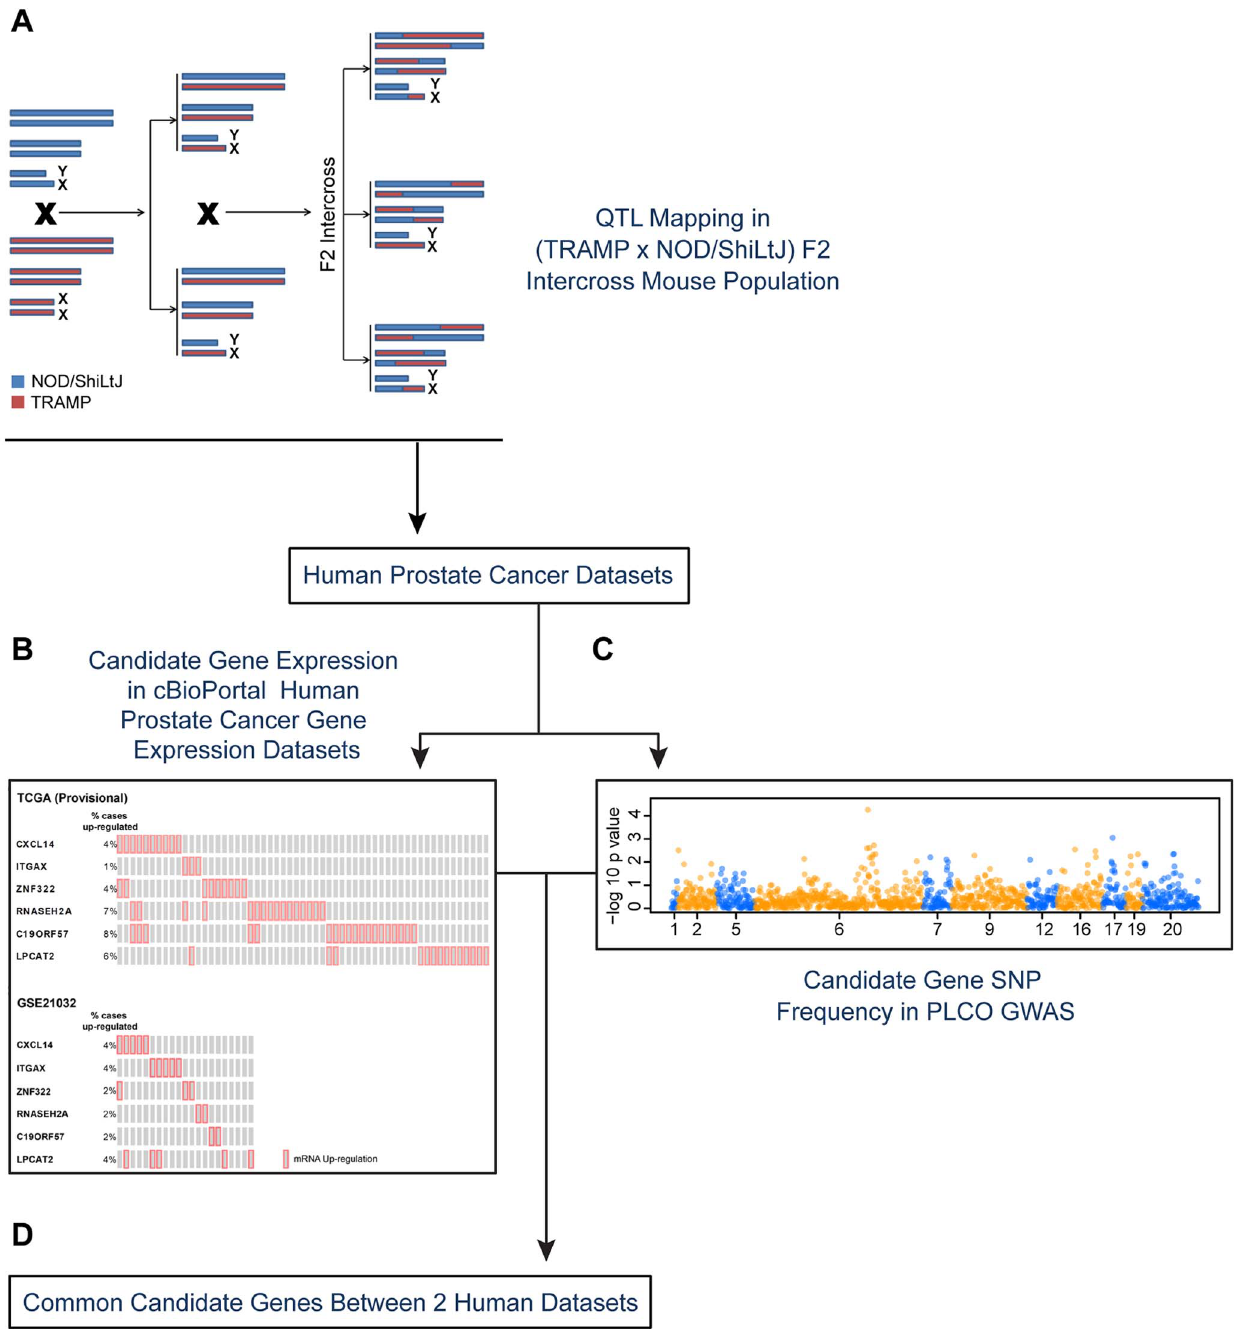
Figure 1. Experimental strategy for identifying novel susceptibility genes for aggressive prostate cancer. Candidate aggressive disease modifier genes were identified in an F2 intercross population involving the TRAMP mouse model of prostate tumorigenesis and the NOD/ShiLtJ strain of mouse, which is highly susceptible to aggressive disease development (A). This strategy involved QTL mapping to identify genomic regions associated with aggressive disease traits, followed by eQTL mapping and gene expression-trait correlation analyses to nominate candidate modifiers. Following this, a strategy involving two types of data derived from human prostate patients was used to nominate the highest priority candidate genes: (B) human prostate cancer primary tumor gene expression datasets; and (C) a human prostate cancer GWAS dataset. Only those genes designated as being associated with aggressive disease development in both the tumor gene expression and GWAS datasets were designated as being high priority candidate genes (D). doi:10.1371/journal.pgen.1004809.g001 (reviewed in [16]; e.g., age at death, distant metastasis free survival As would be expected in humans, larger primary tumors were [DMFS], presence or absence of lymph node metastasis, lymph positively correlated with a younger age of death, a substantially node metastasis burden; Figure S1) in the F2 mapping population. reduced DMFS, an increased risk of lymph node metastasis, and an